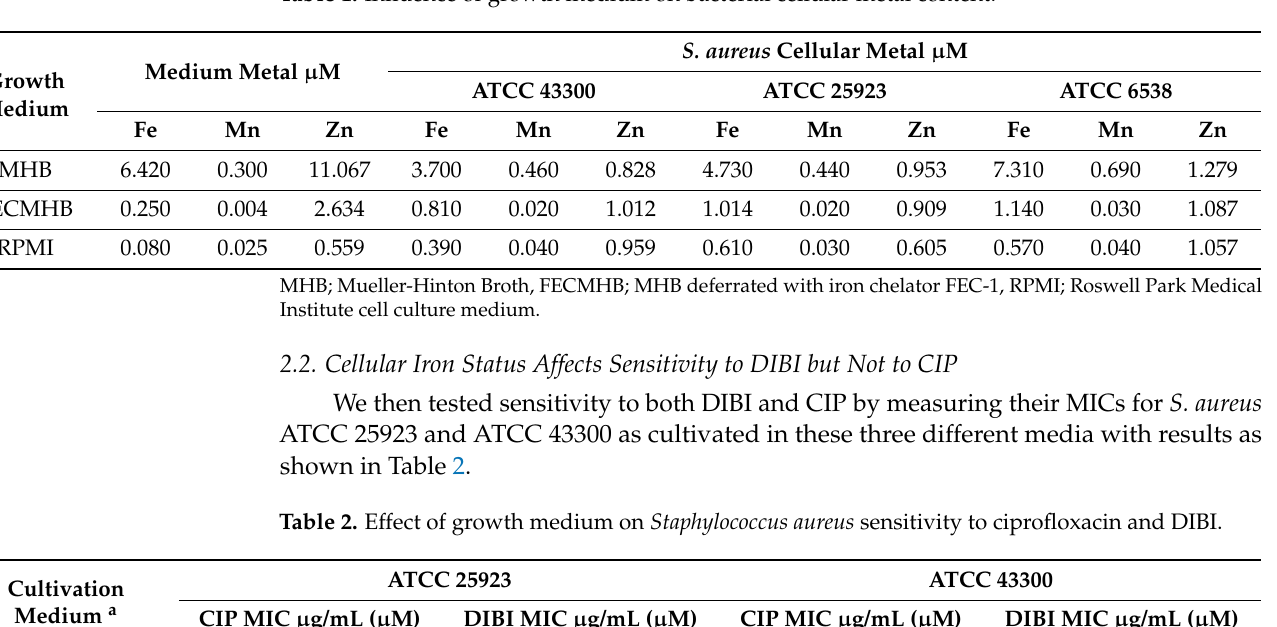
Table 1. Influence of growth medium on bacterial cellular metal content.